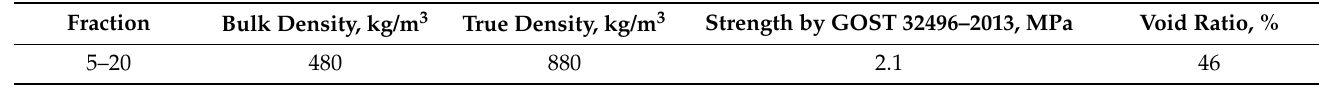
Table 4. Physical and mechanical characteristics of expanded clay